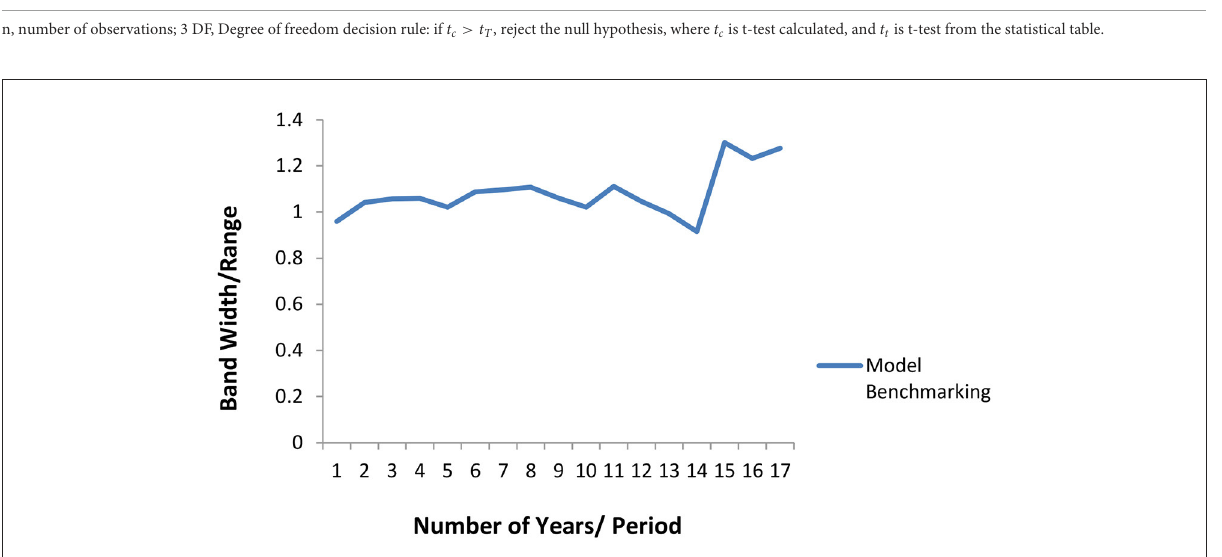
FIGURE4 Plot of OPREM Gold Impact Factor components series (Component